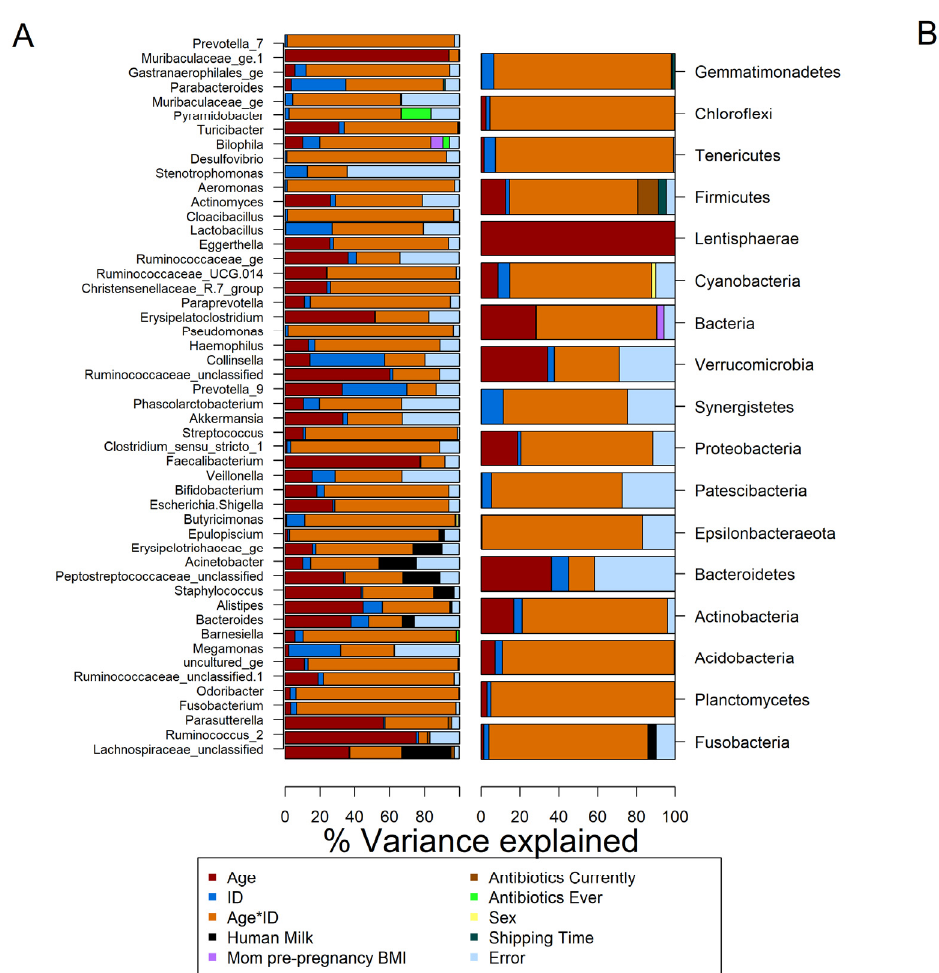
Figure 1. Model parameters significantly associated with the predicted abundance at the genus ( A ) and phylum ( B ) levels. The figure also illustrates the variance in the predicted abundance of a single genera or phyla explained by each parameter.